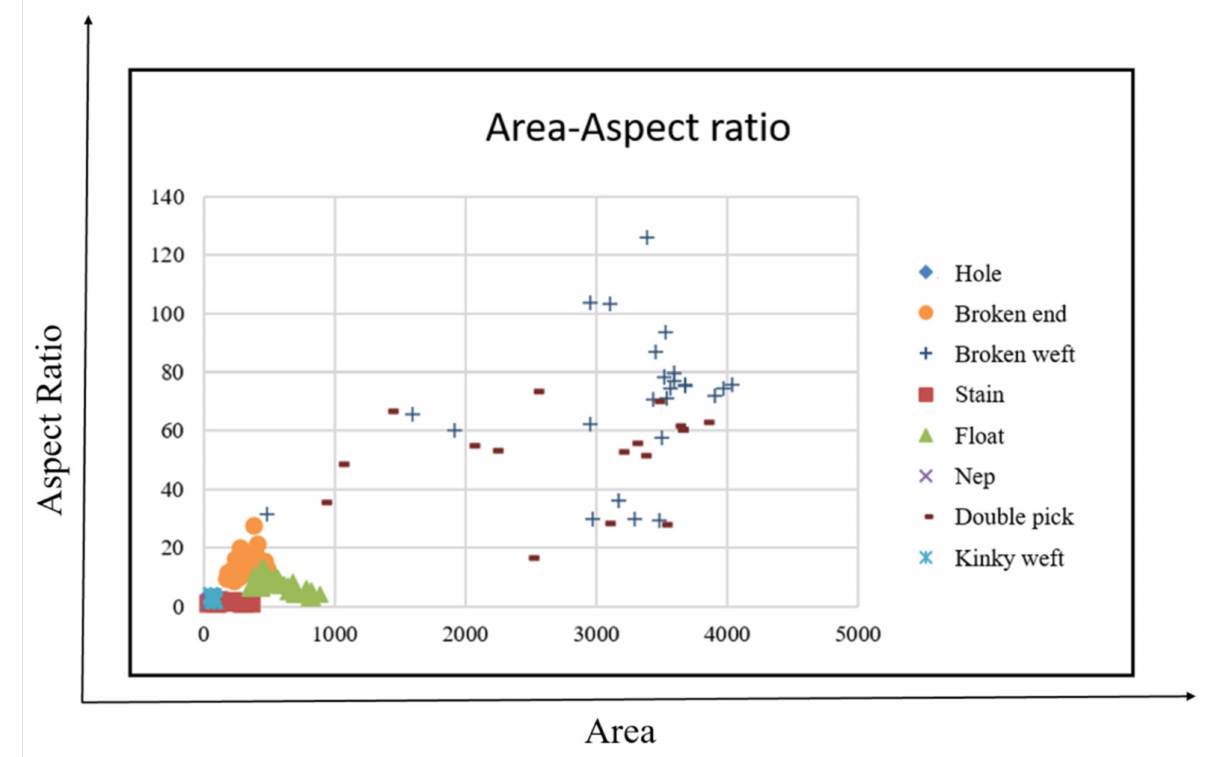
Figure 12. Area versus aspect ratio feature distribution.